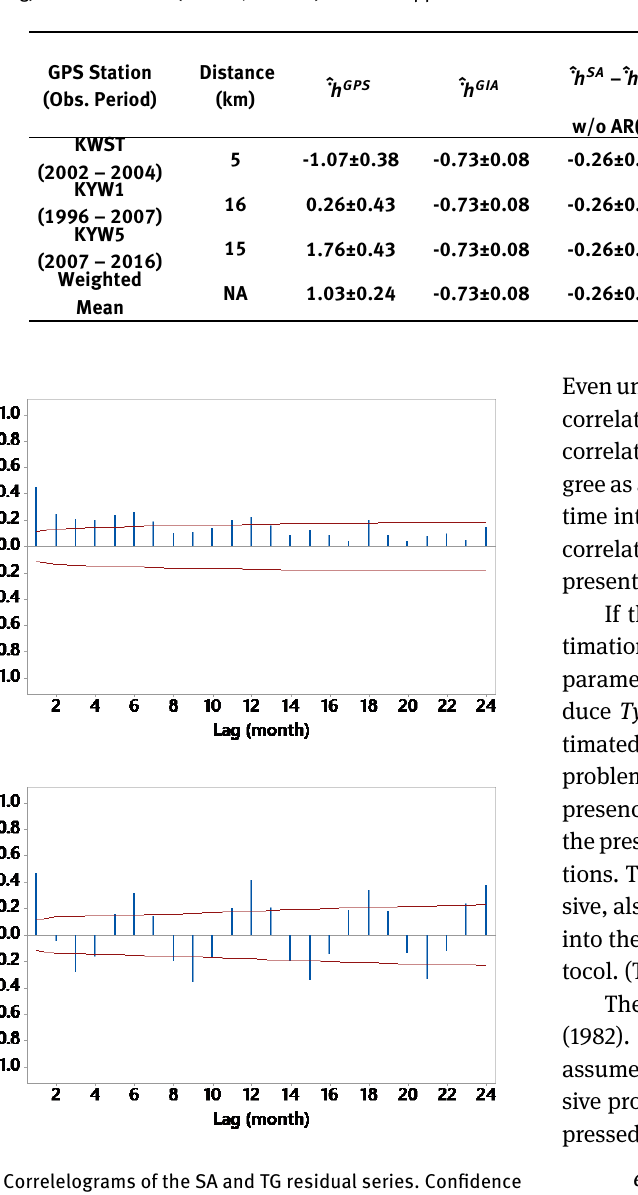
Table 1. All velocities are in mm/yr at Key West TG station. GIA velocities were calculated using the ensemble average of 13 GIA models (Iz et al., 2017g) at the location: (24.56o, -81.81o). NA: Not Applicable.